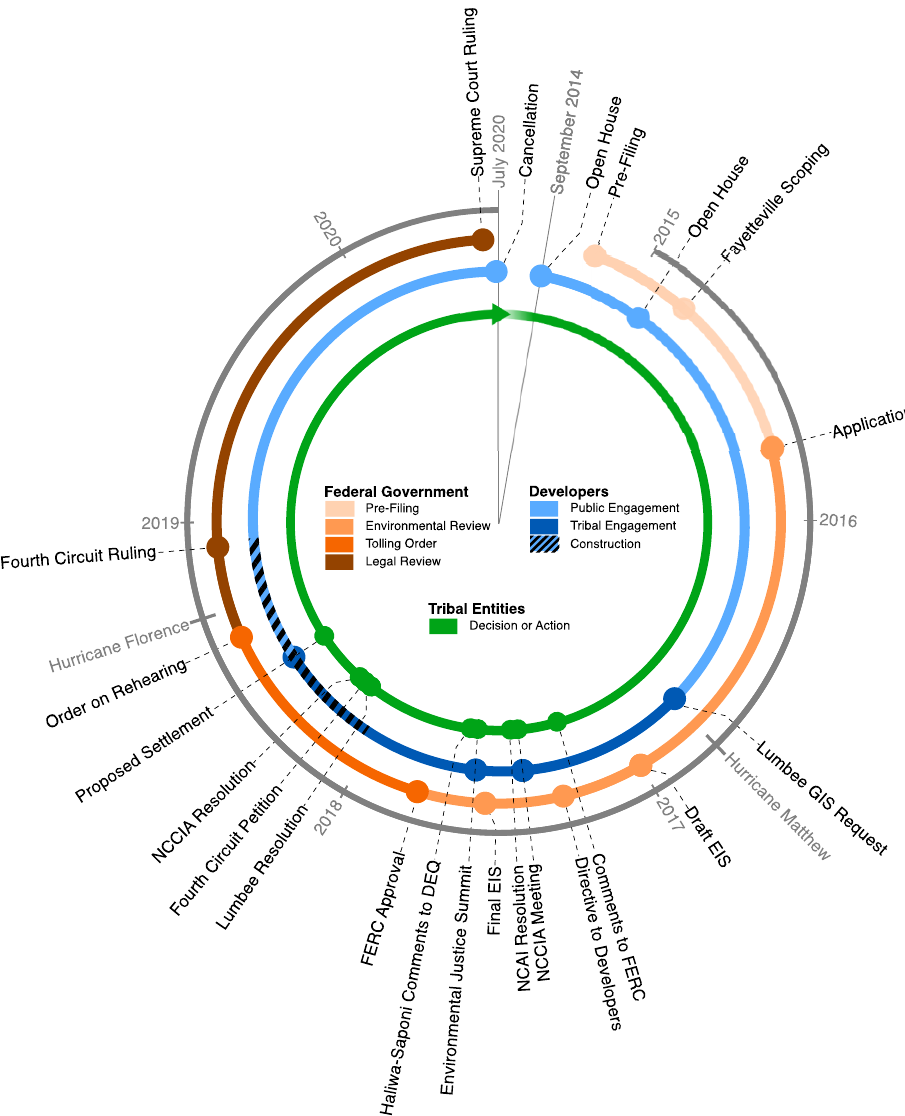
Figure 2. Timelines of activity by federal government, developers, and Tribal entities related to the Atlantic Coast Pipeline. Outer dial (gray) indicates year and timing of major hurricanes affecting Lumbee territory. Concentric rings show timing of key phases (colors) and specific events (black text).